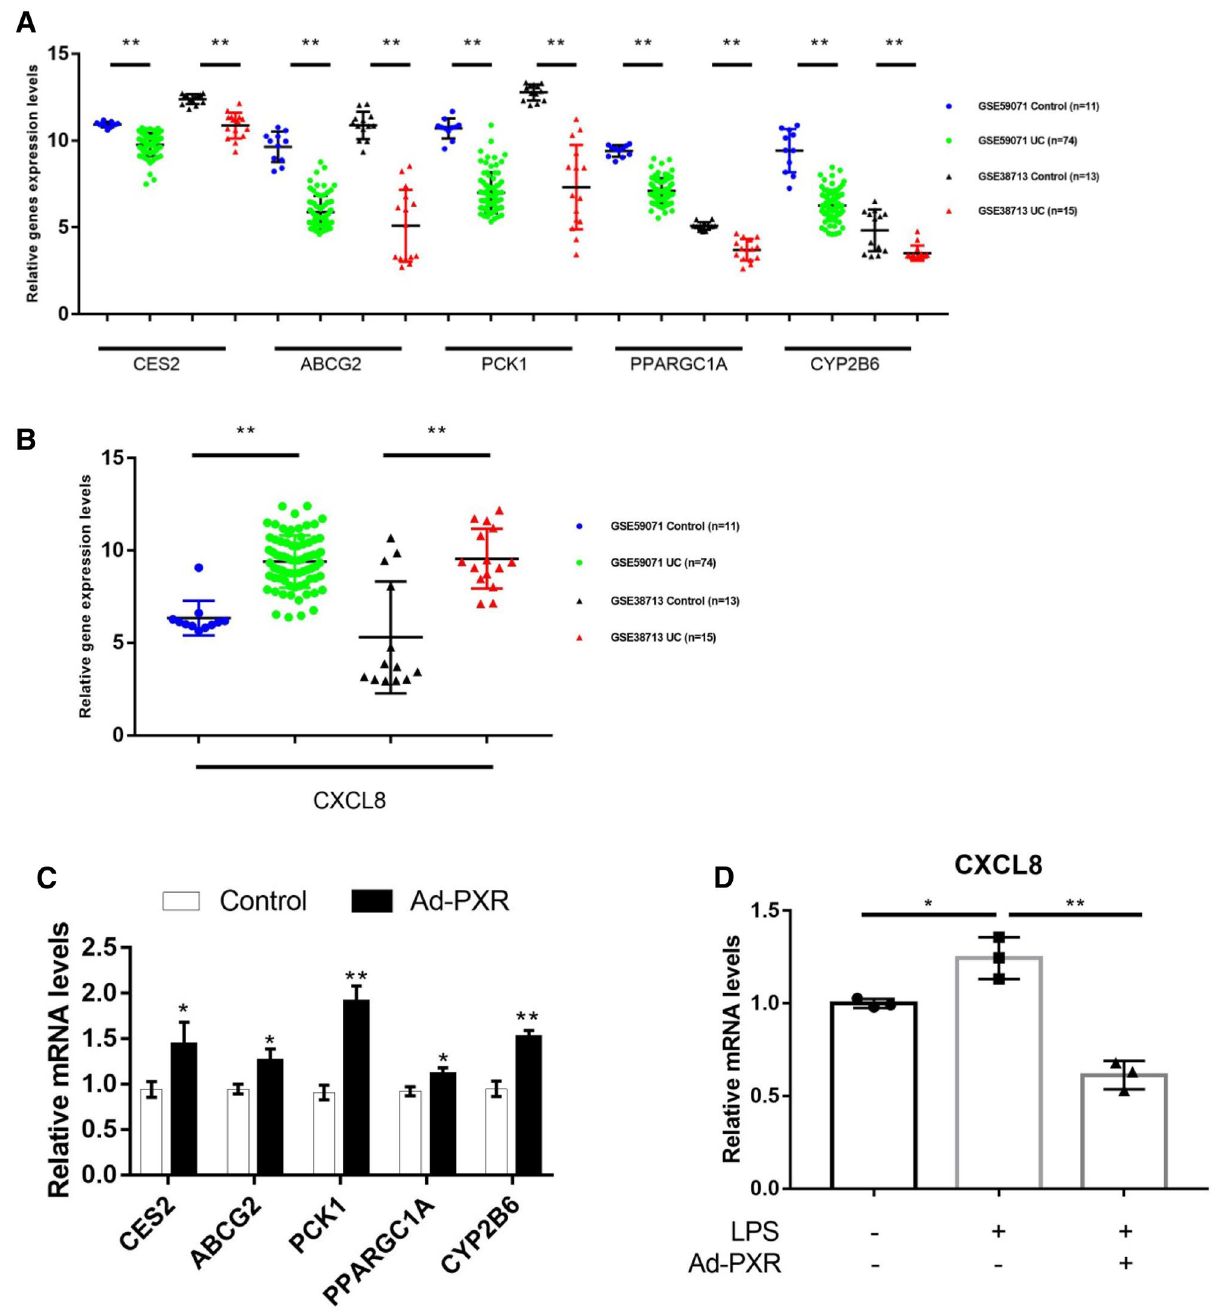
Figure 6. CES2, ABCG2, PCK1, PPARGC1A, CYP2B6 and CXCL8 were regulated by PXR. ( A ) The expression level of CES2, ABCG2, PCK1, PPARGC1A and CYP2B6 in GSE59071 and GSE38713 datasets. ( B ) The expression level of CXCL8 in GSE59071 and GSE38713 datasets. ( C ) PXR increased the expression of CES2, ABCG2, PCK1, PPARGC1A and CYP2B6 in HCT116 cells. HCT116 cells were infected with Ad-PXR or mock infection for 24 h. The mRNA levels of CES2, ABCG2, PCK1, PPARGC1A and CYP2B6 were quantified by RT-qPCR. ( D ) PXR reduced the up-regulated expression of CLX8 induced by LPS. HCT116 cells were infected with Ad-PXR or mock for 24 h before exposure to LPS (1 μg/ml) for 12 h, the mRNA levels of CXCL8 were quantified by RT-qPCR. Data shown are as mean ± S.E. of at least three independent experiments. * P < 0.05 versus control; ** P < 0.01 versus